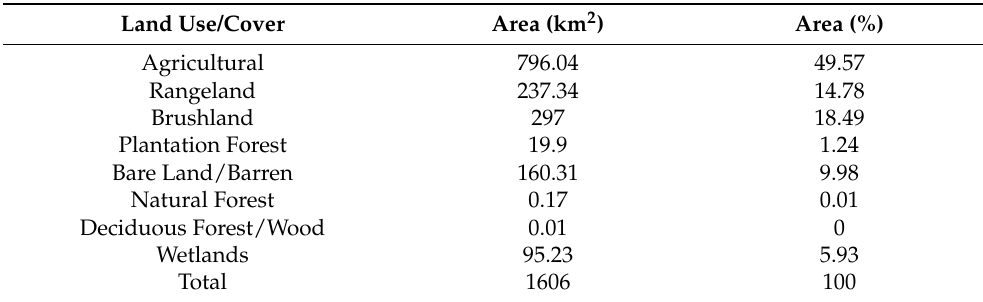
Table 1. Land use/land cover classes in the study catchment (source: Ministry of Water and Energy